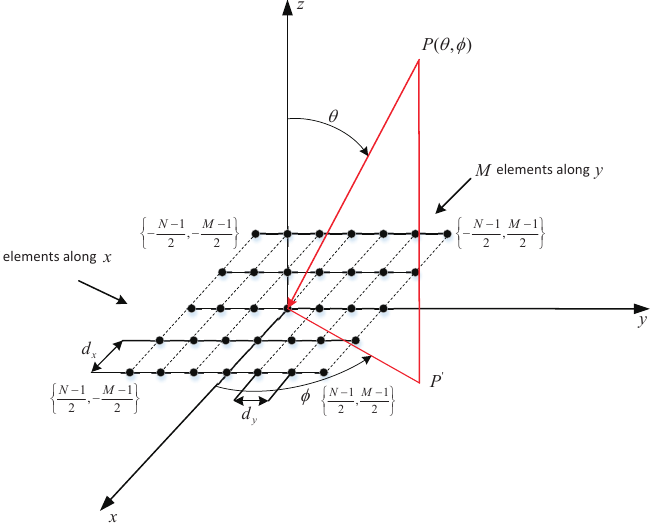
Figure 1. Uniform rectangular planar array